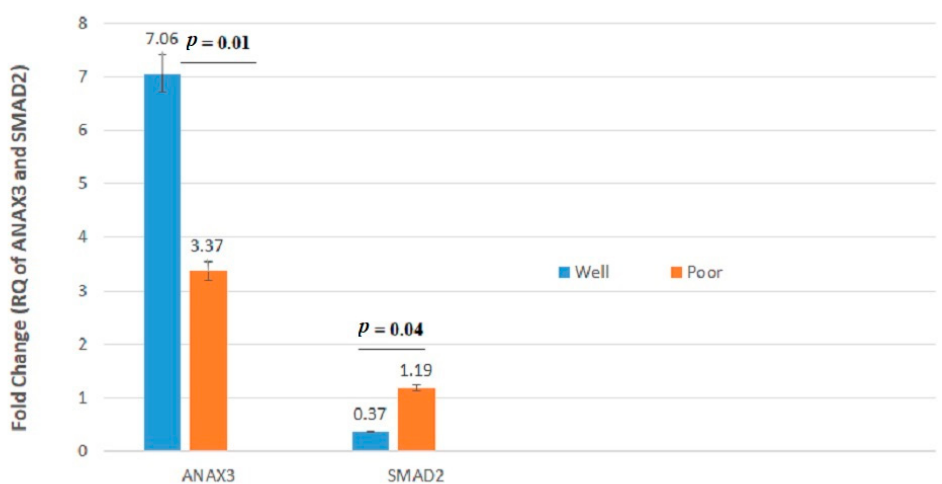
Figure 2. ANXA3 and SMAD2 mRNA relative quantification (RQ) established by RT-qPCR analysis according to histological grade. Gene expression levels of these genes differed significantly between well- and poorly differentiated cancers.